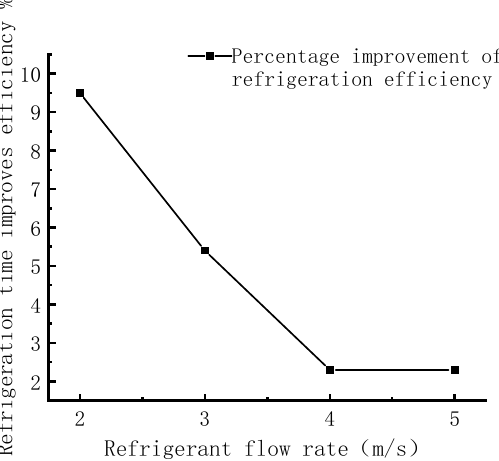
Figure 8. Refrigeration efficiency change curve with the increase of refrigerant flow rate.